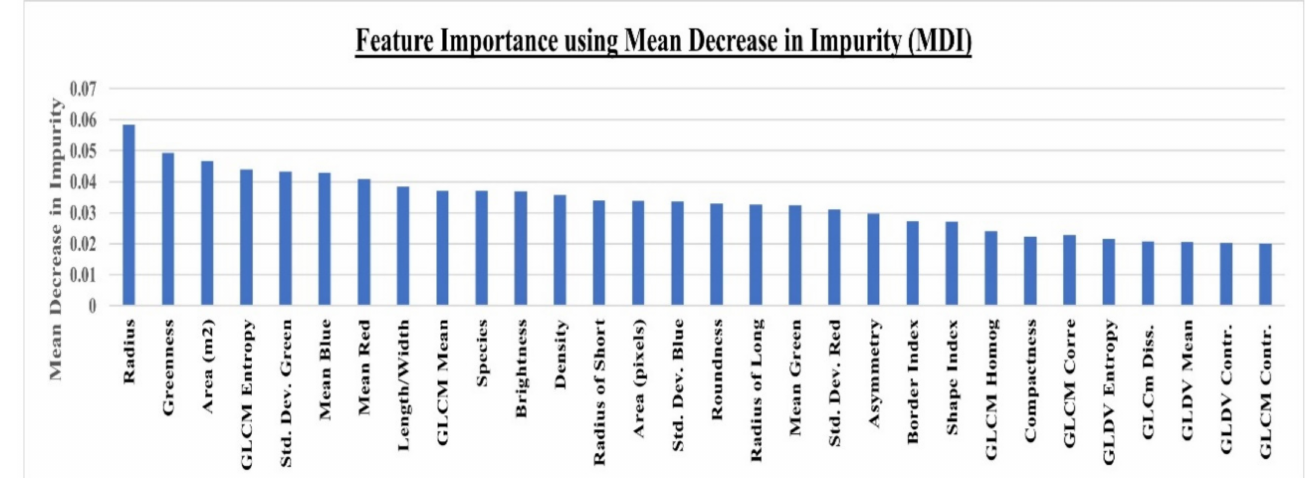
Figure 5. Feature importance values for the random forest classification input features for large trees based on the mean decrease in impurity (MDI)